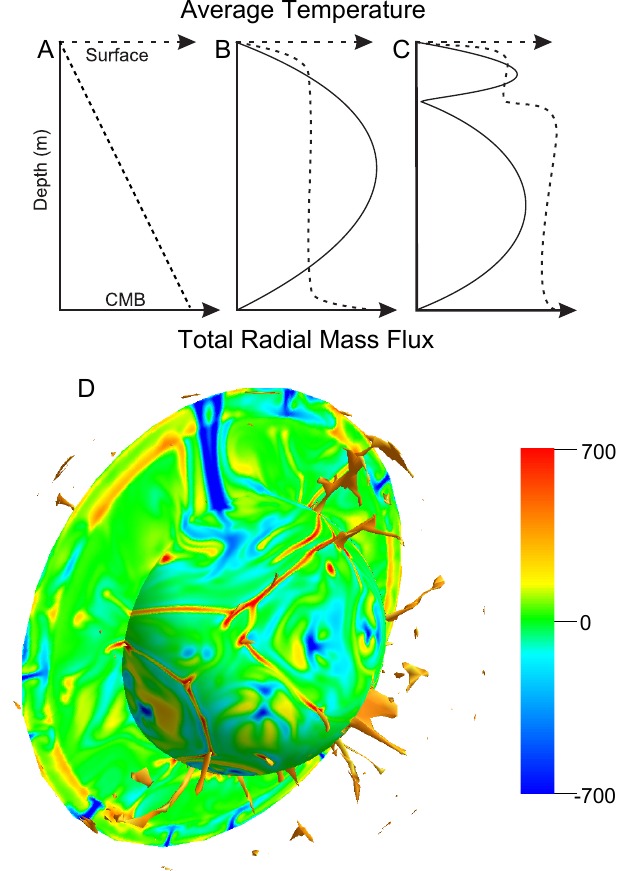
Fig. 2. Criteria for defining whether convection is layered. (A) shows the constant thermal gradient of a purely conductive regime. The dashed line in Part (B) shows the whole mantle convection thermal structure, illustrating the large temperature gradients at its boundaries. The solid line represents the absolute radial mass flux, which is zero at the two boundaries. For whole mantle convecting it peaks in mid-mantle. (C) illustrates a layered system. In this case, the solid line shows that the absolute radial mass flux will be a min- imum at the phase change, which also leads to an additional ther- mal boundary layer, illustrated by a step in the dashed line, across the phase change. (D) shows a cross-section and a radial surface through the thermal anomaly field. Blue is colder than the radial av- erage and red hotter. The visualisation demonstrates a transitional case. There is a large degree of layering, with the 660km phase change clearly visible by temperature contrasts across the interface, but there is also some passage of material